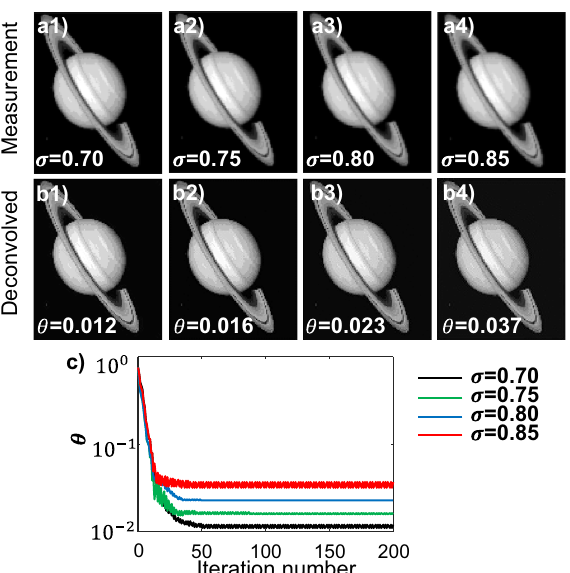
Figure 4. 8-bit fixed-point Richardson solver of a discrete Richardson-Lucy deconvolution problem. ( a ) Convolution measurements from the four kernels with σ of (a1) 0.70, (a2) 0.75, (a3) 0.80, and (a4) 0.85. (b1-b4) Deconvolved images using 8-bit fixed-point iterations from (a1-a4). ( c ) Normalized error vs. iteration steps for the reconstructions in (b1-b4).